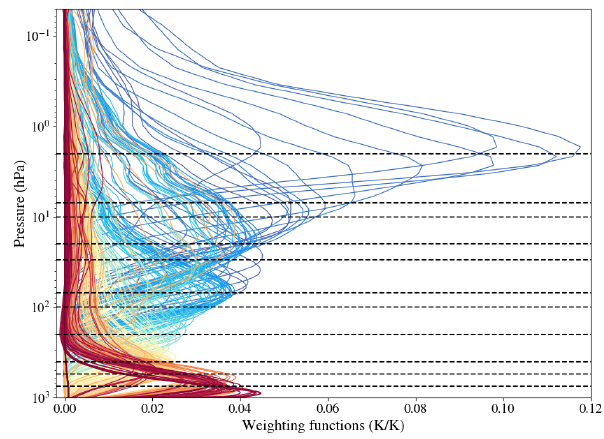
Figure 2. Weighting functions for the 231 selected IASI chan- nels. Dashed horizontal lines represent the 11 pressure levels for which the temperatures are computed. The colours of the weight- ing functions represent the wavenumbers of the selected channels (blue for the channels around 700cm − 1 , red for the channels around 2200cm − 1 )